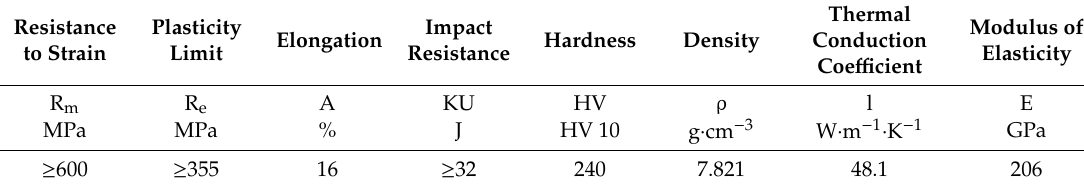
Table 3. Mechanical and physical properties of the C45 steel [1].